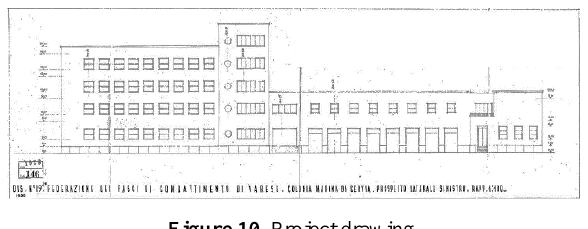
Figure 10 . Project drawing. Left-side elevation.